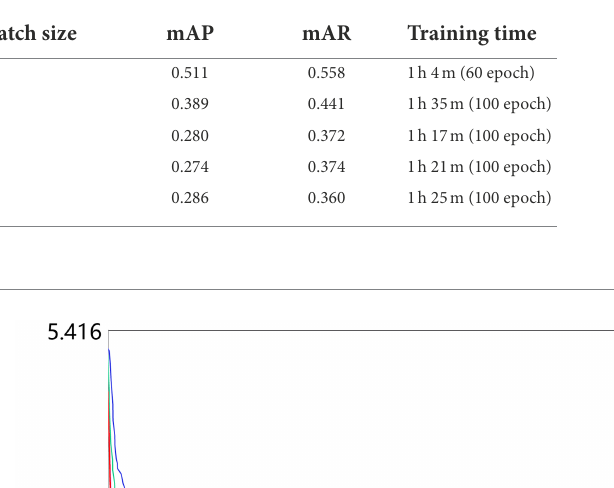
TABLE 2 Evaluation results of different batch